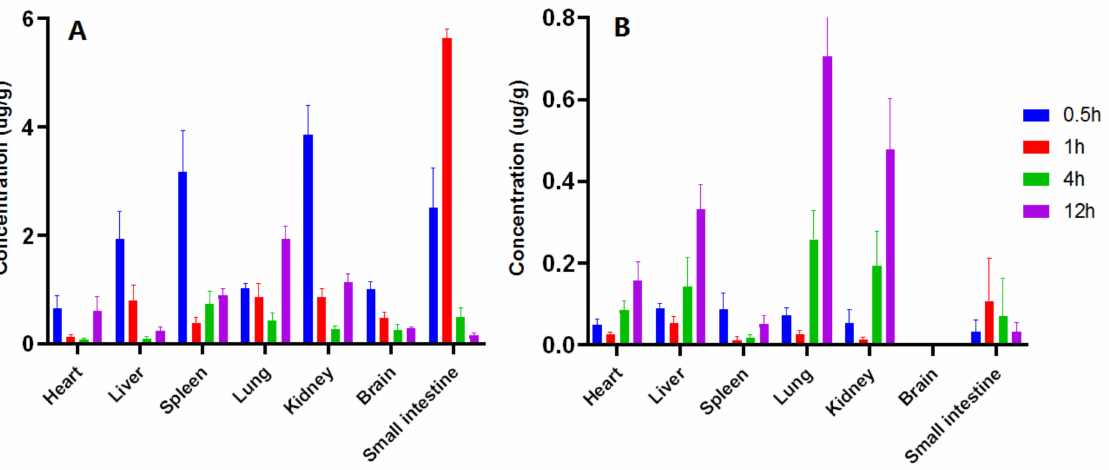
Figure 4. The concentration of metabolites GAMG ( A ) and GA ( B ) in various tissues at different time